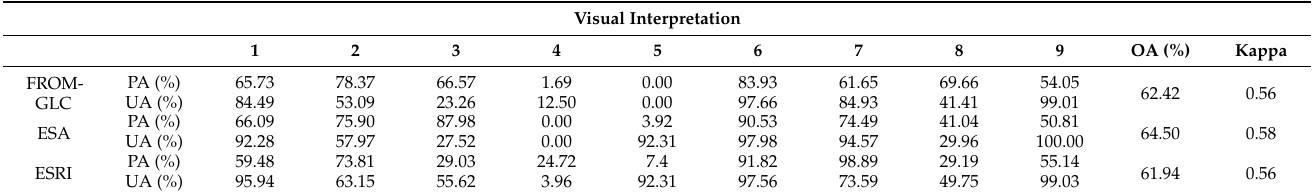
Table 7. Accuracy evaluation results based on visual interpretation